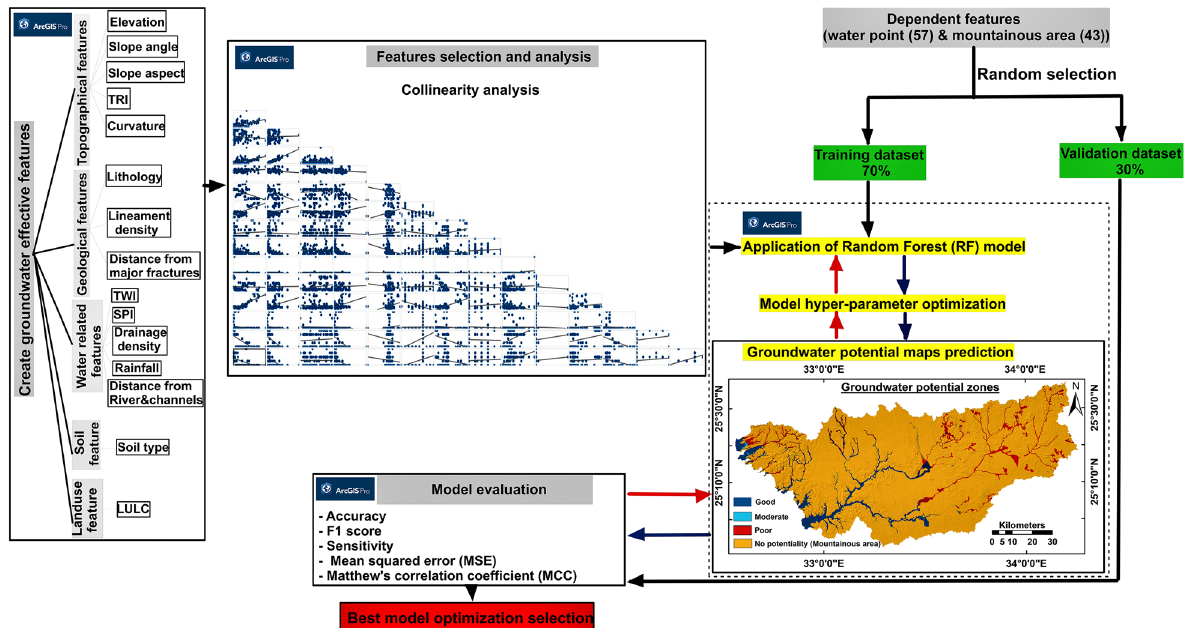
Fig. 3 A machine learning flowchart is developed to predict the groundwater potential